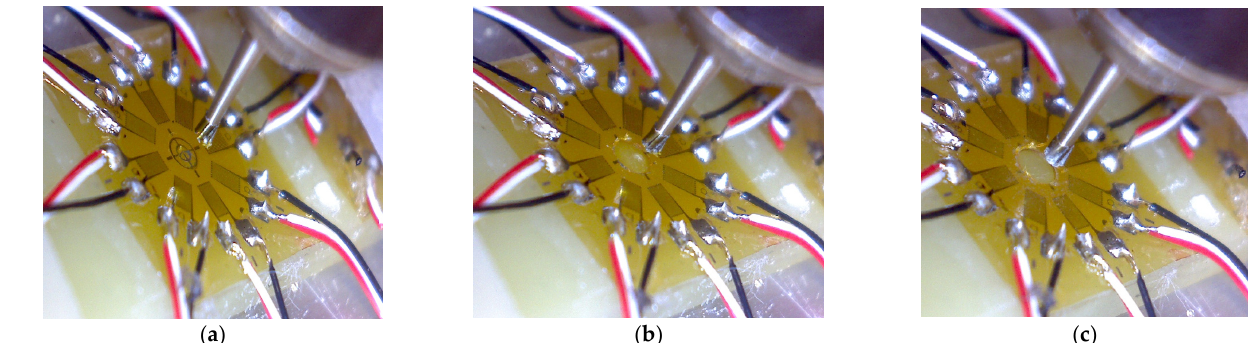
Figure 15. Removal of the stain gauge rosette foil for precisely determining the surface of the sample via stepwise drilling. The following steps are highlighted: ( a ) before drilling, ( b ) intermediate stage (very thin foil film remained) and ( c ) the first view of the surface of the sample.